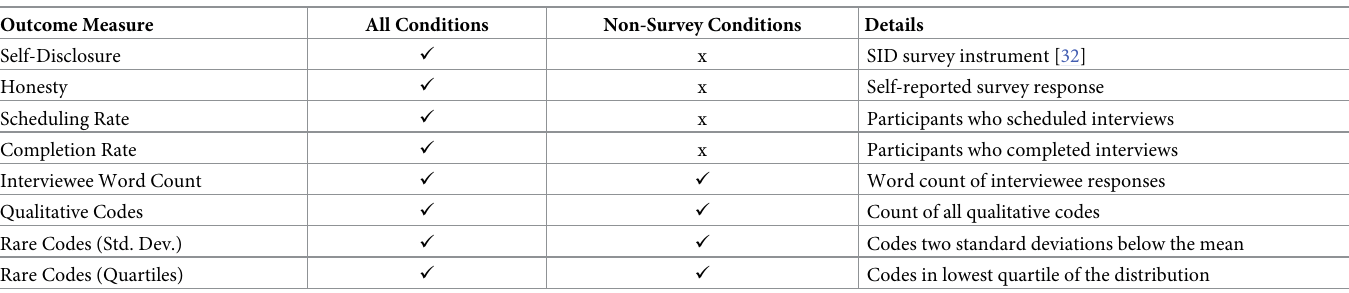
Table 3. Summary of statistical